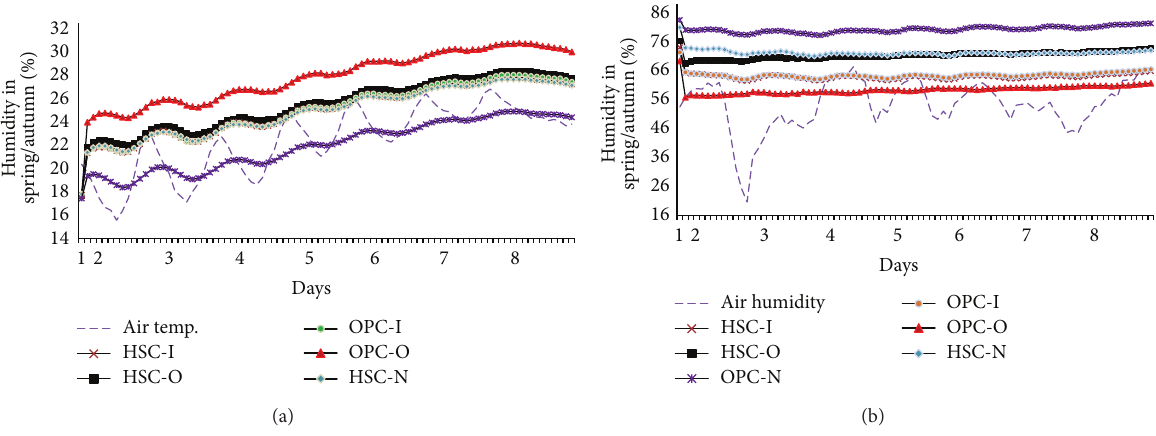
Figure 8: Measurement results of the interior temperature and humidity in